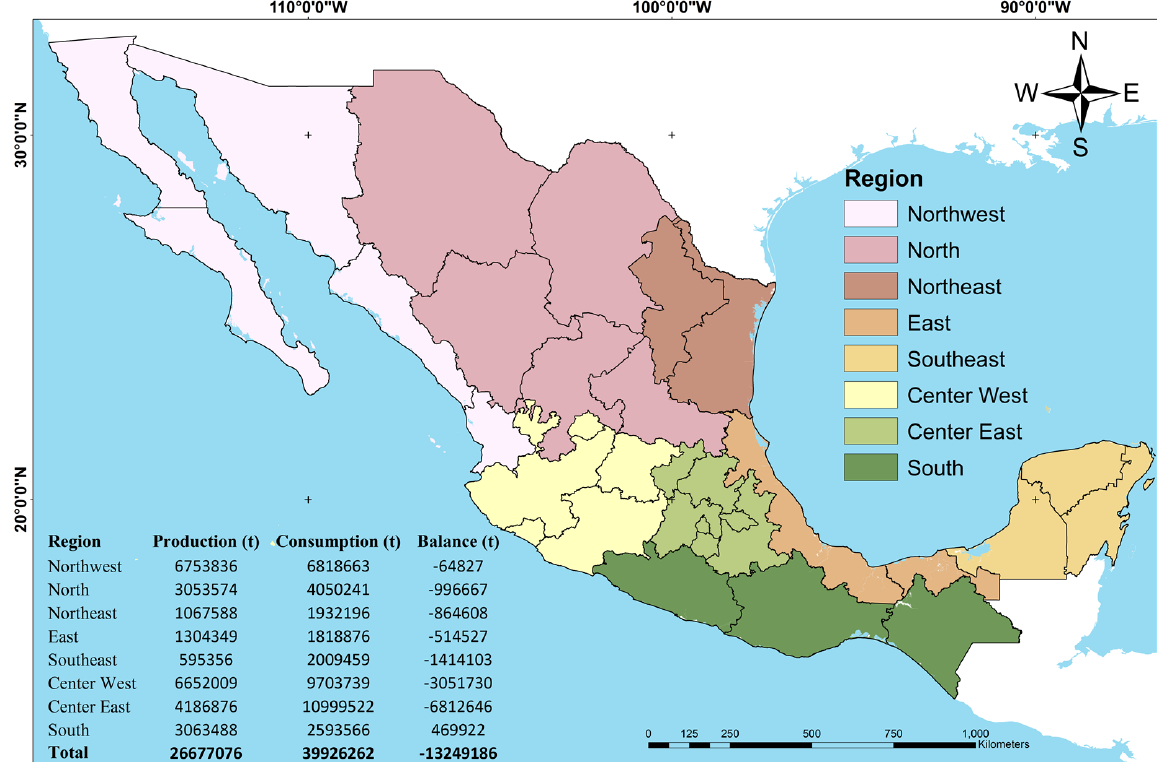
Figure 3. Agrifood balance between production and consumption of grain maize in Mexico per economic region from 2013 to